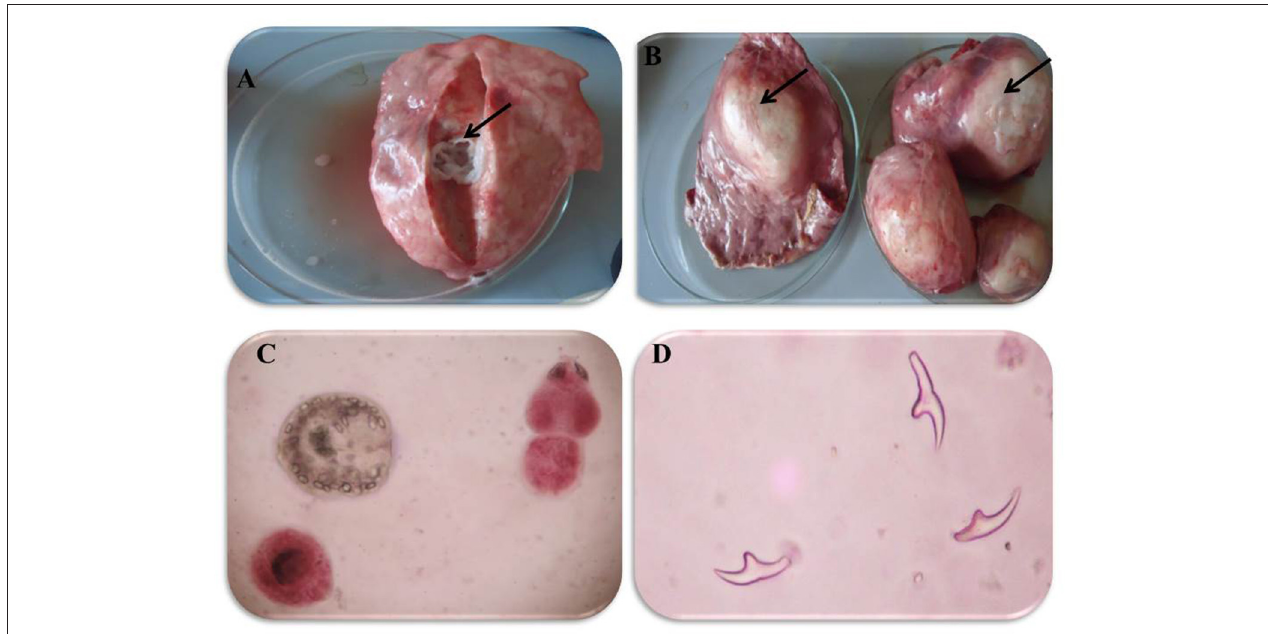
FIGURE 1 | Morphological appearance of Hydatid cyst in the lung of camels. (A) Solitary sterile hydatid cysts. (B) Multiple hydatid cysts. (C) Multiple scolices in viable and non-viable fertile hydatid cyst, using 0.1% Eosin stain (X400) and (D) different-shaped and sized hooks in fertile viable-hydatid cysts.